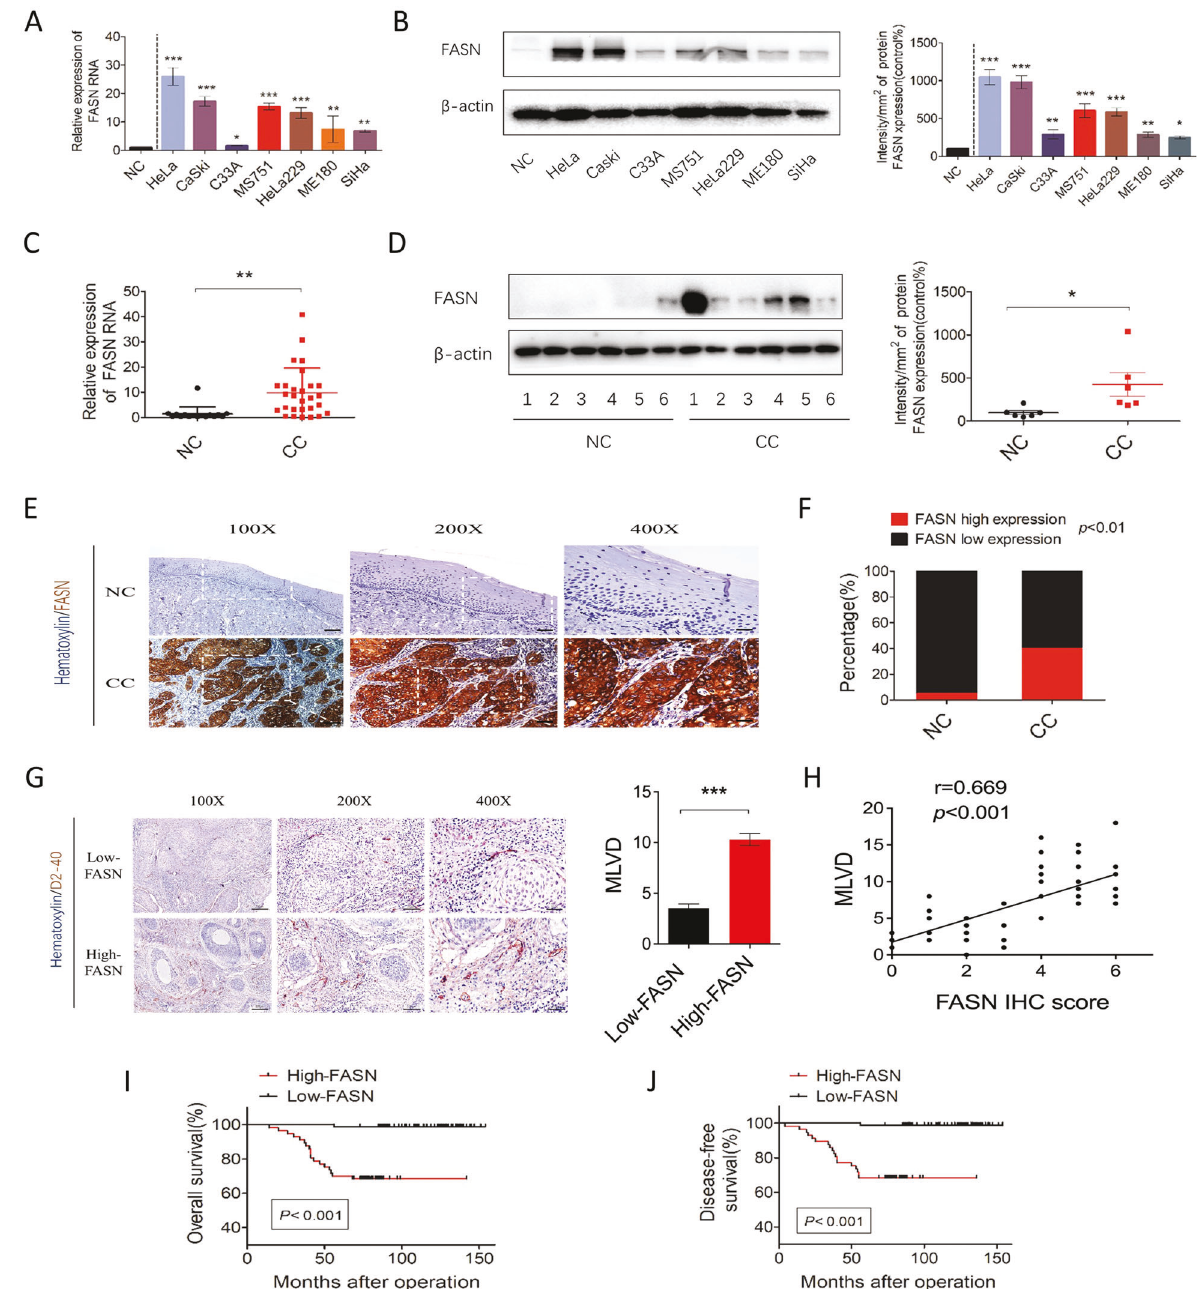
Fig. 2 High expression of FASN predicts poor prognosis and is related to MLVD in cervical cancer patients. A qRT-PCR analysis of FASN mRNA expression levels in various CC cell lines and normal cervical controls. NC = normal cervix. B Western blot analysis and quanti fi cation of FASN protein levels in CC cell lines and the NC group. C qRT-PCR analysis of FASN mRNA expression levels in the NC ( n = 16) and CC ( n = 28) groups. D Western blot analysis and quanti fi cation of NC ( n = 6) and CC ( n = 6) tissue samples. E Representative IHC images of FASN staining in the NC and CC tissue samples. Bar in 100×, 200×, 400 magni fi cations = 200 µm, 100 µm, 50 µm respectively. F Percentage of low and high FASN expression in the NC and CC groups based on the IHC staining results. G Representative IHC images of D2-40 staining in the CC groups with low and high FASN expression. Quanti fi cation of microlymphatic vessel density (MLVD) is shown. Bar in 100×, 200×, 400 magni fi cations = 200 µm, 100 µm, 50 µm respectively. H Correlation analysis of FASN IHC scores and MLVD. I and J Overall survival and disease-free survival analysis of CC specimens based on FASN expression. * P < 0.05; ** P < 0.01; *** P <